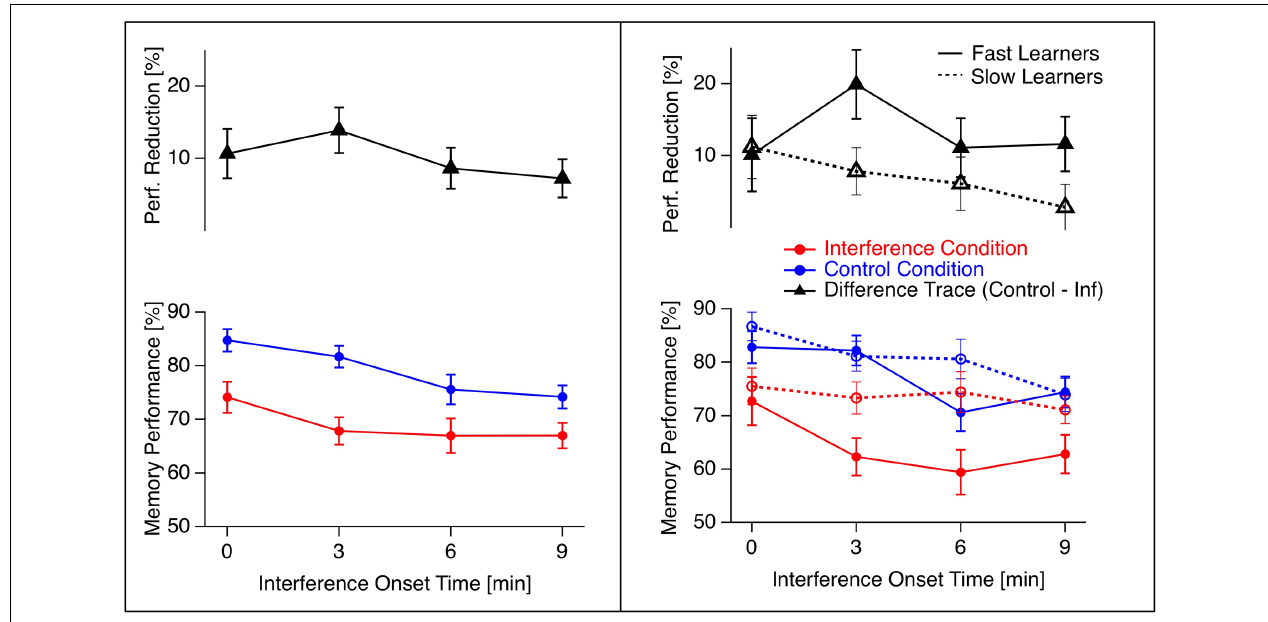
FIGURE 2 | Temporal profile of retroactive interference (grand means). Mean memory performance in the interference experiment (red traces with circles) and the control experiment (blue traces with circles) together with the difference traces (control data minus interference data; black traces with triangles) across all participants (left) and for slow (dotted lines) and fast learners (continuous lines) separately (right) . Error bars indicate standard errors of the means. Standard errors for the difference traces result from the individual difference values of the participants. Interference obviously deteriorates learning performance (difference between red and blue traces) with larger effects for fast compared to slow learners (difference between black traces on the